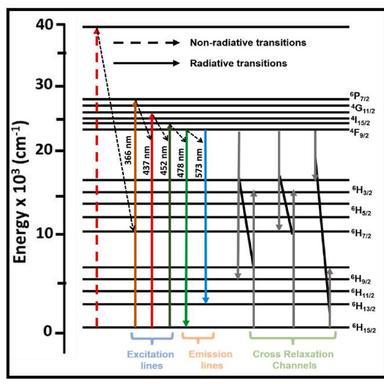
Energy level diagram depicting respective bands of Dy3+ ions.